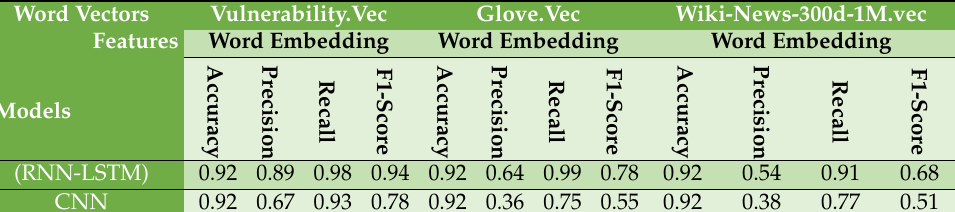
Figure 11. An LSTM node (Source: [27]). Table 7. Comparison of word vectors.